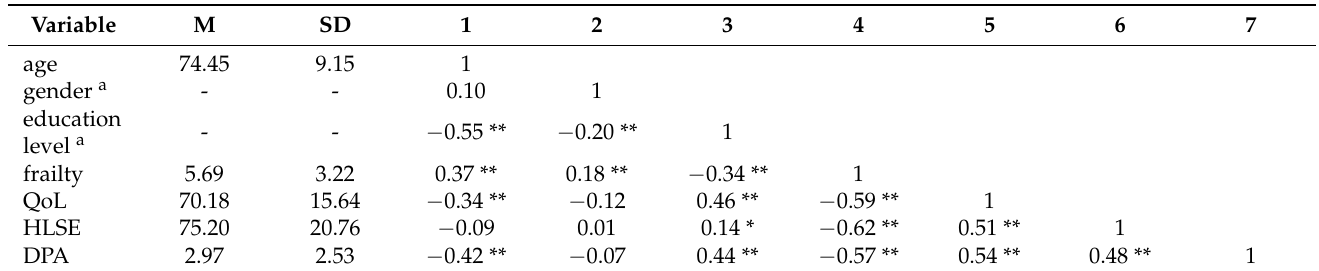
Table 2. Correlation matrix for the main variables ( N =